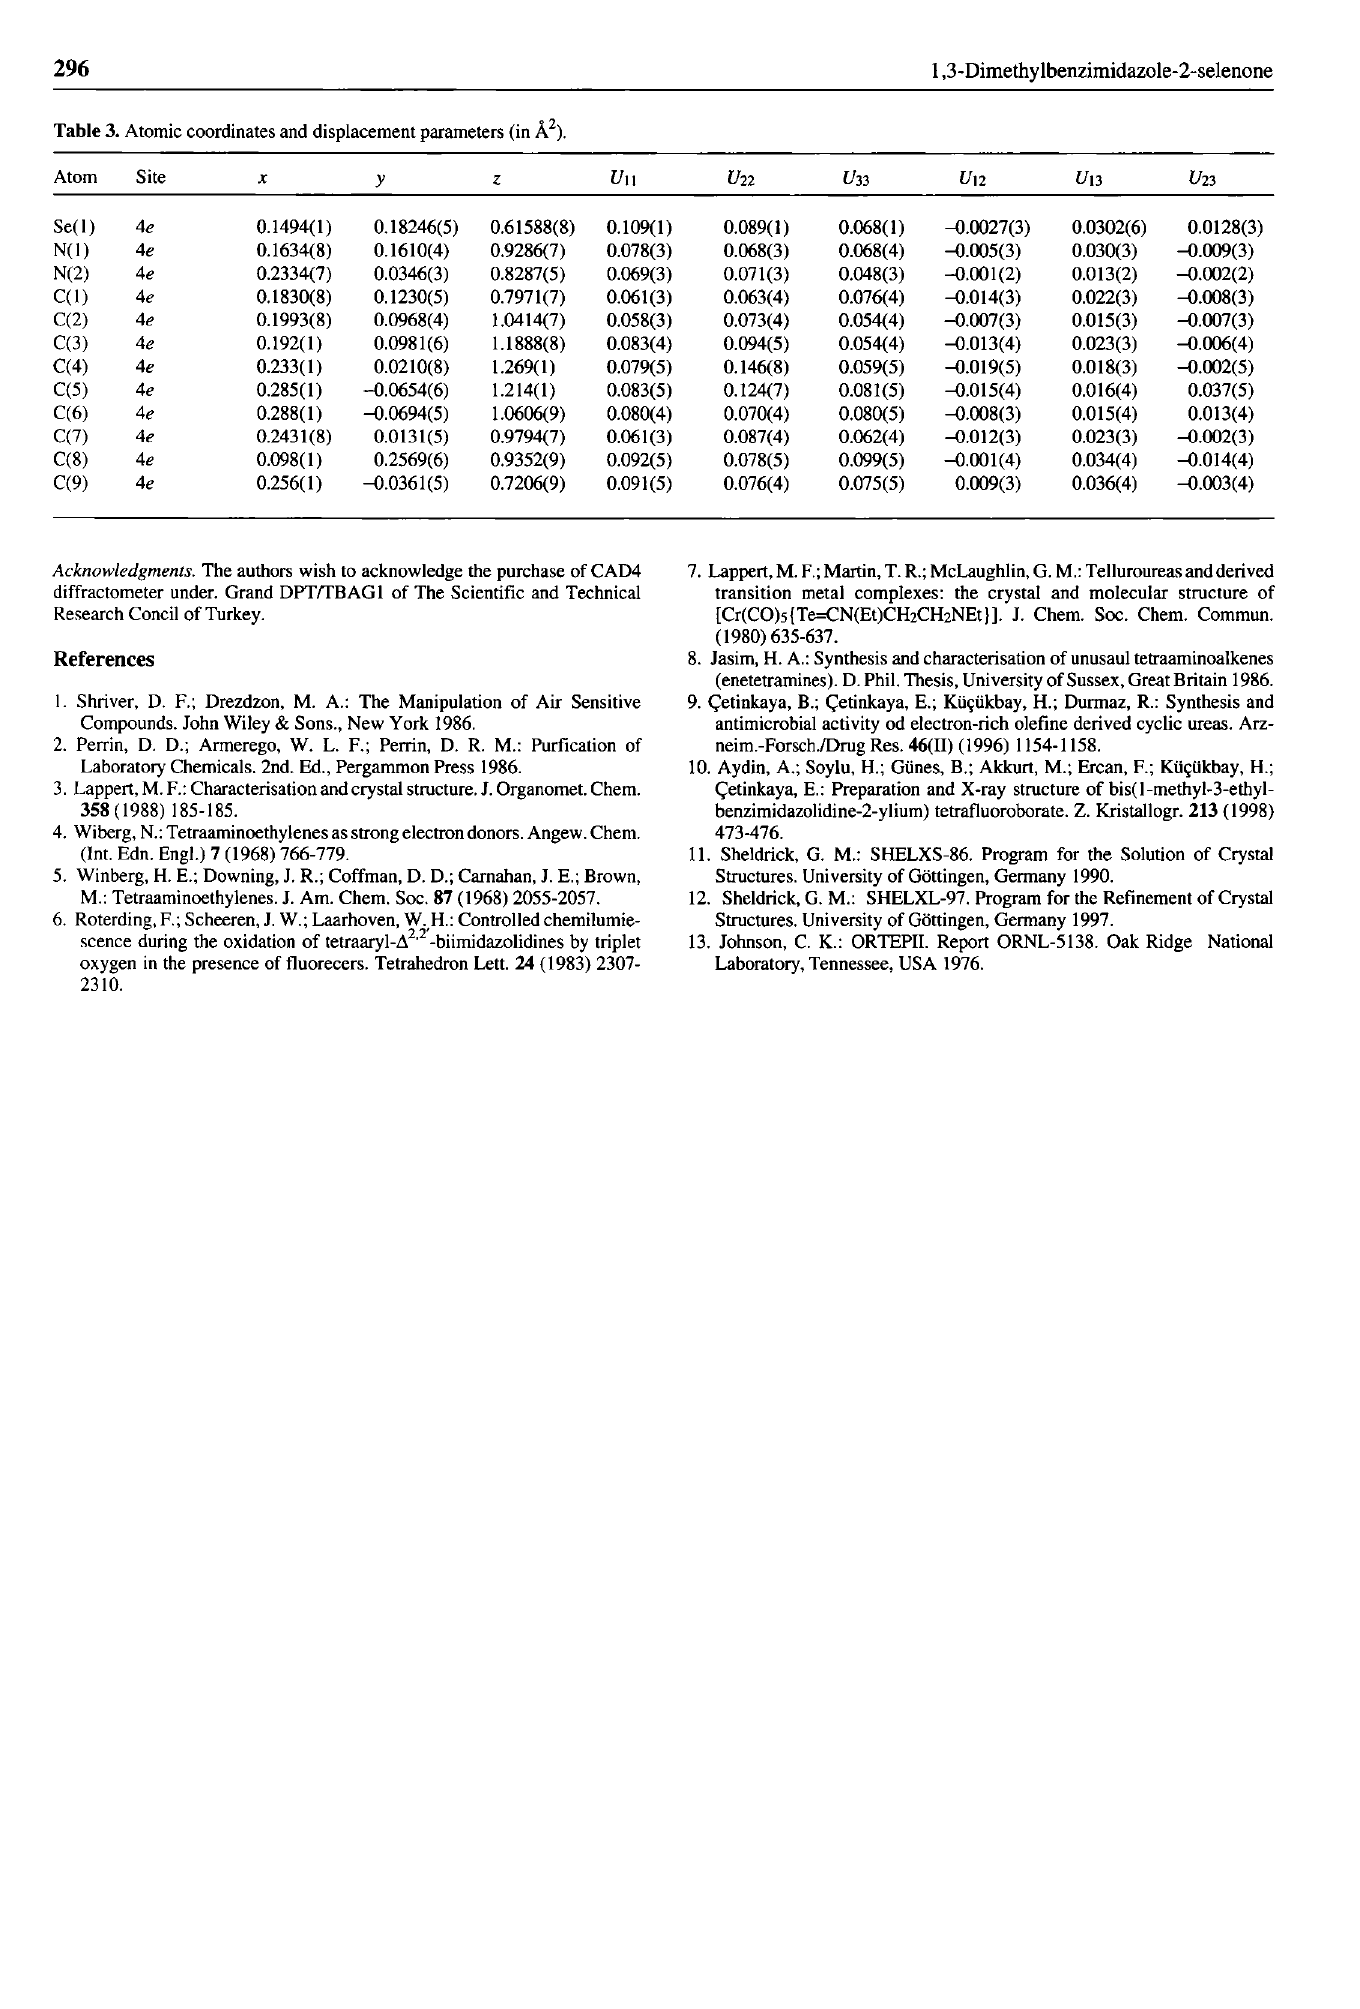
Table 3. Atomic coordinates and displacement parameters (in A 2